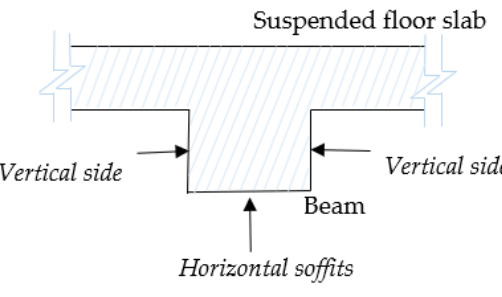
Figure 11. Cross-section of the concrete beam under the floor slab. The planes for ceilings (